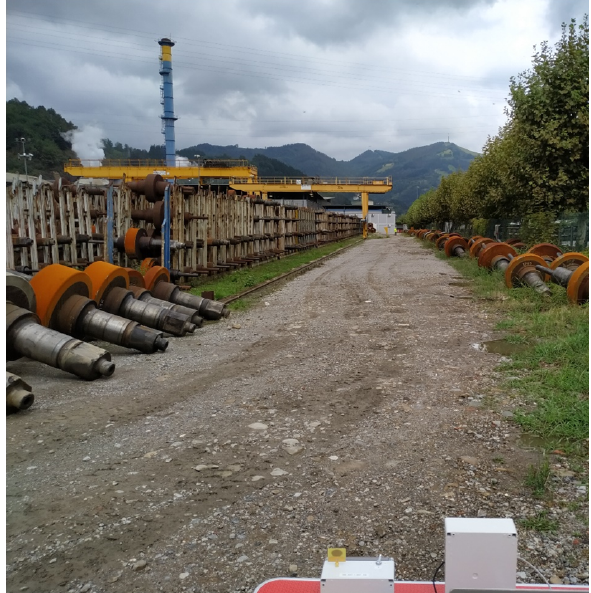
Figure 23. Test site for harsh environment coverage measurements at the ArcelorMittal steel